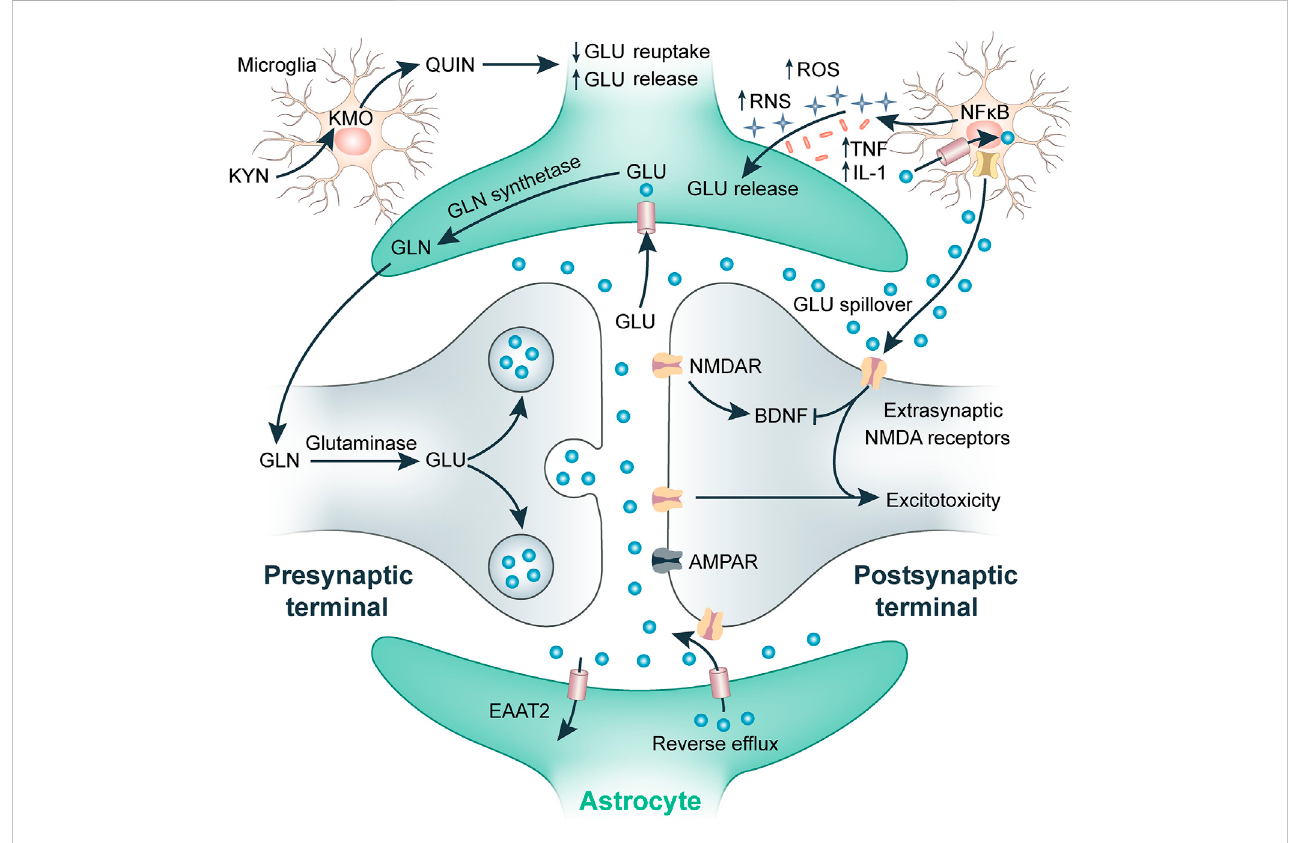
Effect of in fl ammation on glutamate in the